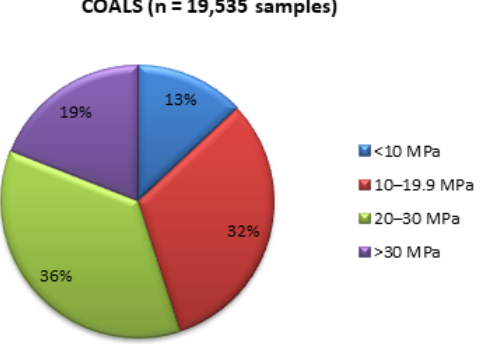
Figure 5. Contribution of USCB coals with medium uniaxial compressive strength in the adopted